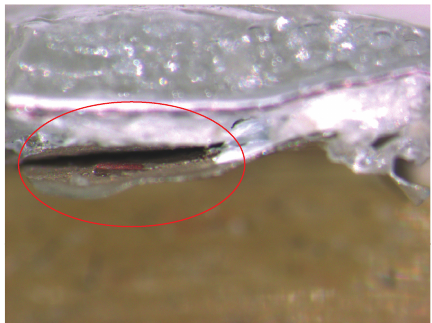
Figure 10: The attachment of the IC fixture pad to the antenna is open; magnification is ×